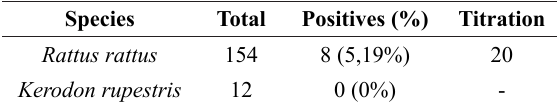
Result of serology analyses for detection of antibodies anti- N. caninum and titration in R. rattus and K. rupestris in the Island of Fernando de Noronha,